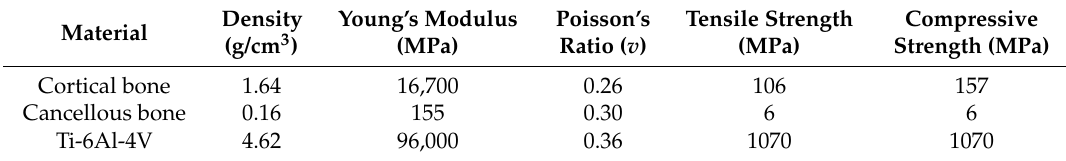
Figure 3. Boundary conditions of finite element (FE) models with ( a ) the straight-type plate fixation and ( b ) the horseshoe-shaped plate fixation. Table 1. Material properties used for the finite element simulation.